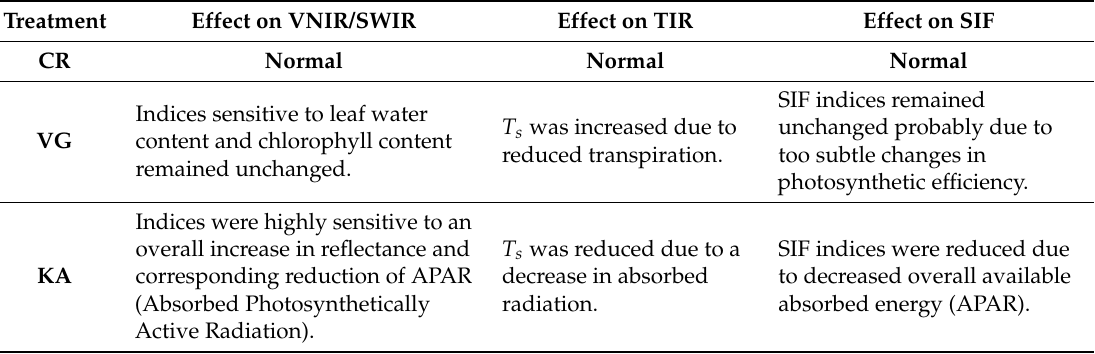
Table 3. Observed effects of treatments on spectral